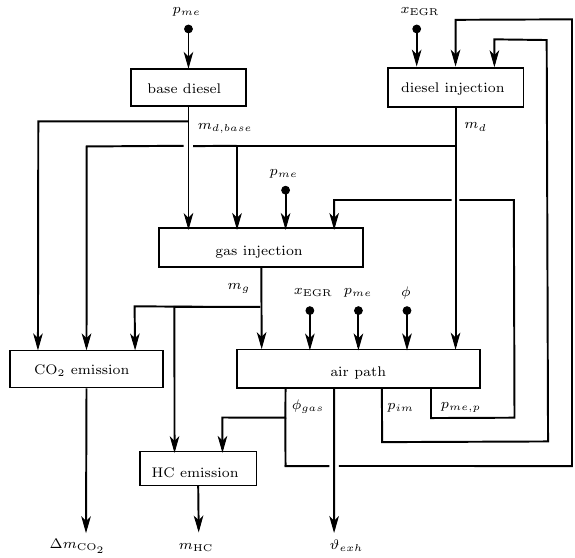
Figure 3. Overview of the model